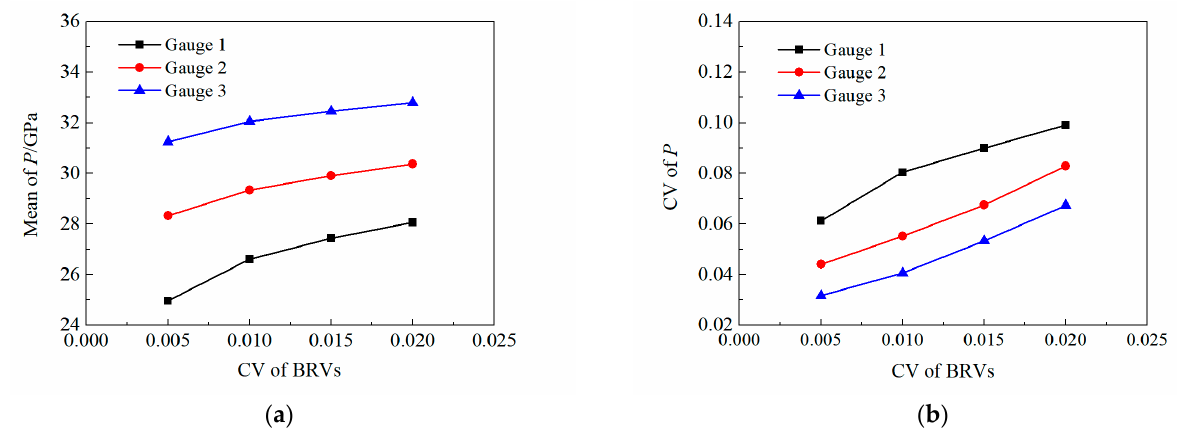
Figure 13. The correlation curves between the statistical characteristics of the P and the CVs of the BRVs under the shock load condition where v is 1000 m/s. ( a ) The correlation curves between the means of the P and the CVs of the BRVs. ( b ) The correlation curves between the CVs of the P and the CVs of the BRVs.